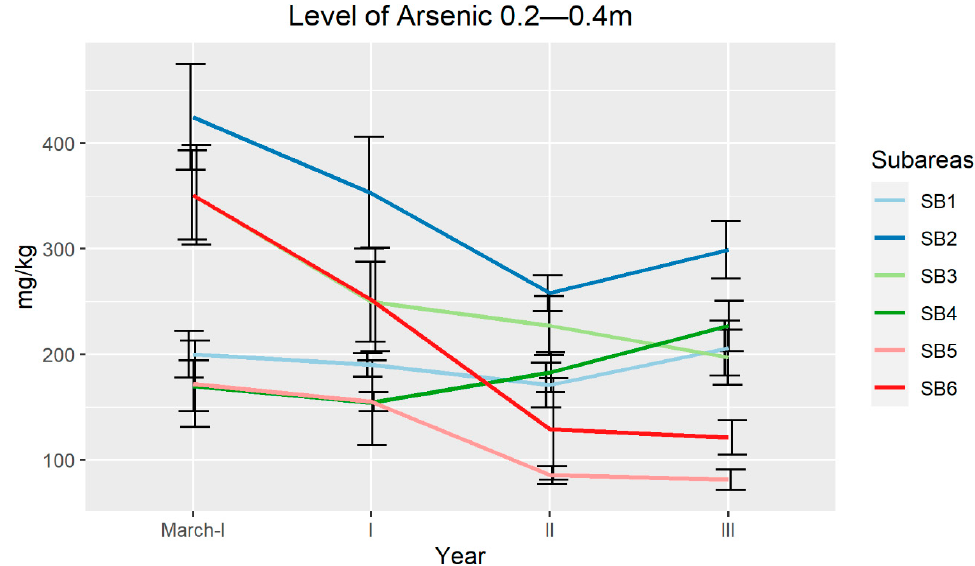
Figure 4. Arsenic average concentration (mg/kg) determined in soils during the three years of field trial at a depth of 0.2–0.4 m. Error bars indicate standard errors.